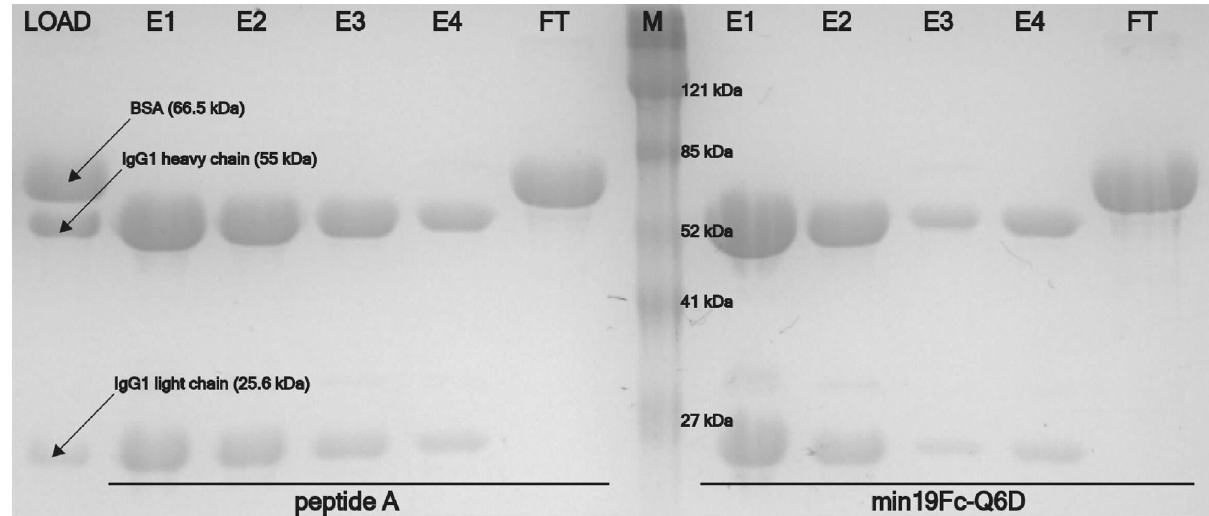
Figure 6. SDS-PAGE analysis of eluted fractions for assessment of binding specificity. A 1:4 mixture (mass ratio) of infliximab (chimeric IgG1) and BSA was loaded on the columns. E1–E4—sequential 1.5 mL elution fractions; FT—low-through; M—protein marker (ProSieve color protein marker,